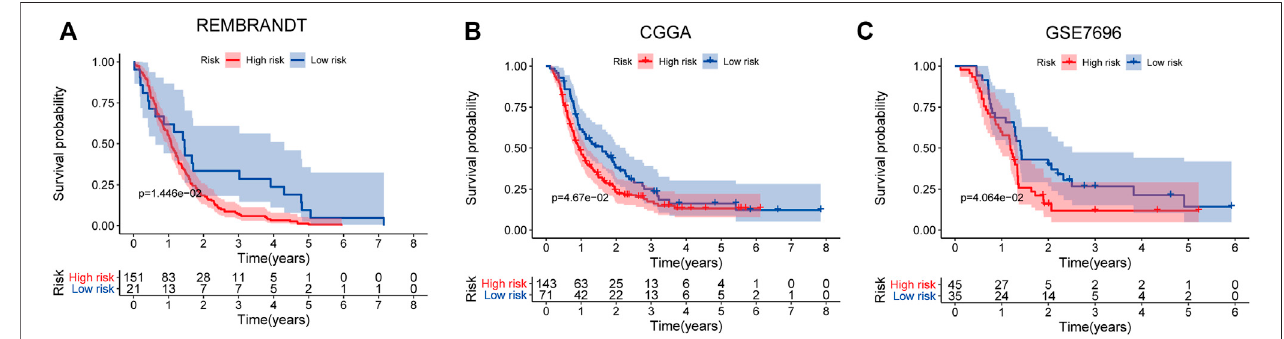
FIGURE 7 | Survival prediction ofthe fi ve-mRNA signature in the independent sets. Kaplan – Meier survival curve of overall survival (OS) between high- and low-risk patients in the REMBRANDT study (A) , Chinese Glioma Genome Atlas (CGGA) datasets (B), and GSE7696 dataset (C) .